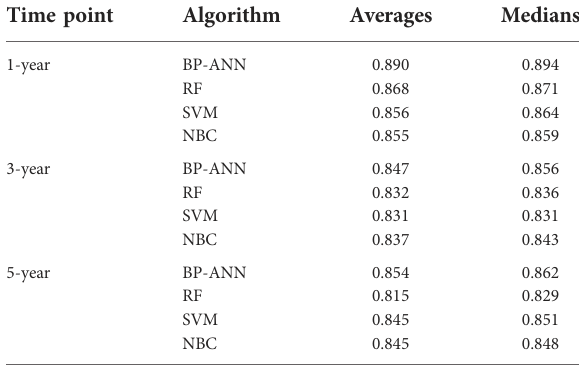
TABLE 4 Results of 10-fold cross-validation method repeated 10 times.